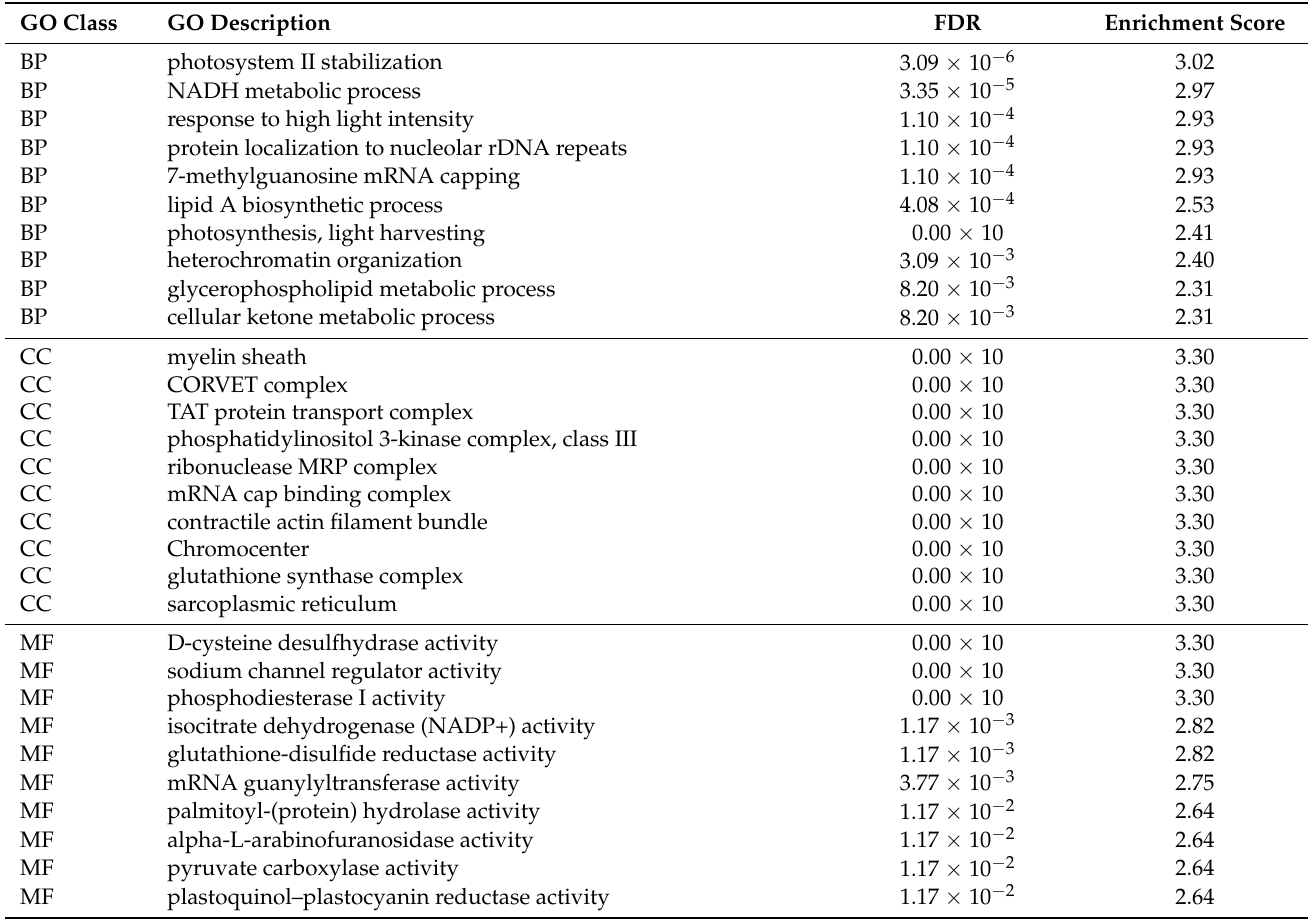
Table 2. The top ten enriched gene ontology (GO) categories in molecular function (MF), cellular component (CC) and biological processes (BPs) in the downregulated group of transcripts at 6